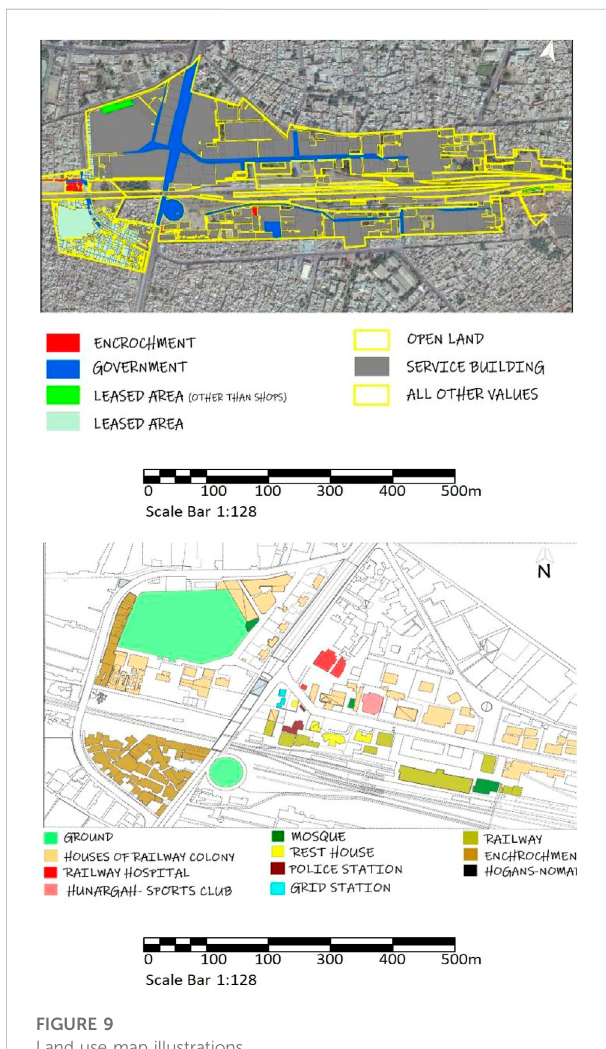
Land use map illustrations.